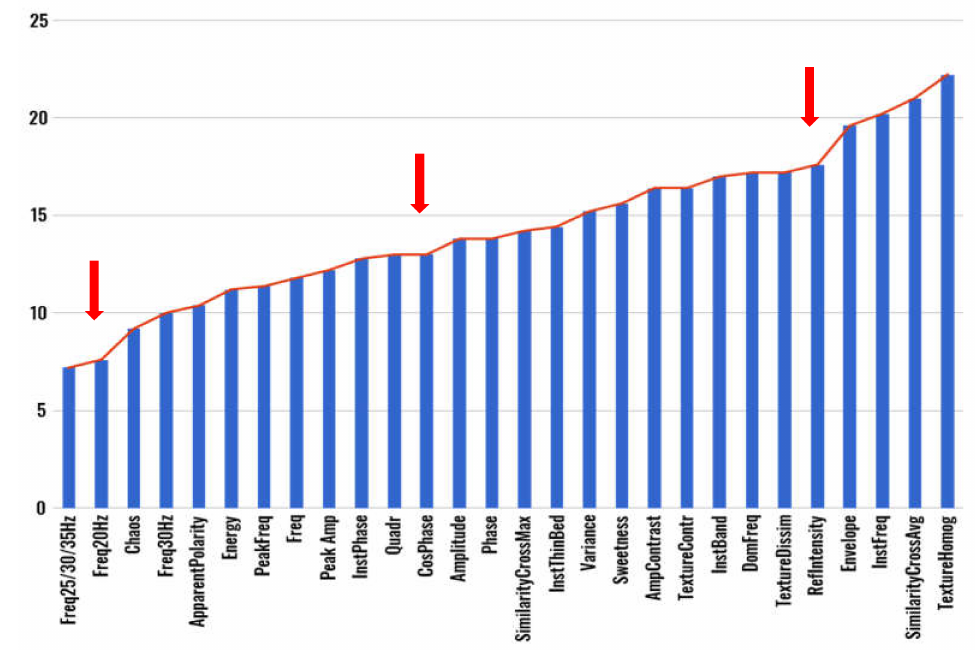
Figure 10. Mean rank of seismic attributes. Red arrows signal the most significant